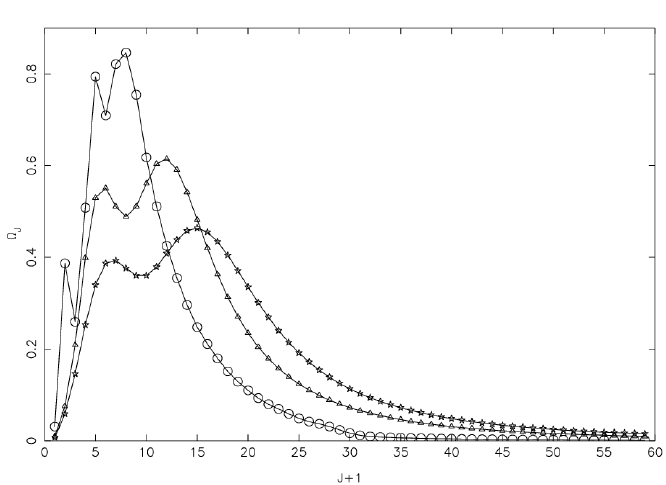
Figure 3. Partial collision strengths for the 3s 2 S 1/2 –3d 2 D 3/2 (6–7) transition of He II, at three energies of: 4 Ryd (circles), 6 Ryd (triangles) and 8 Ryd